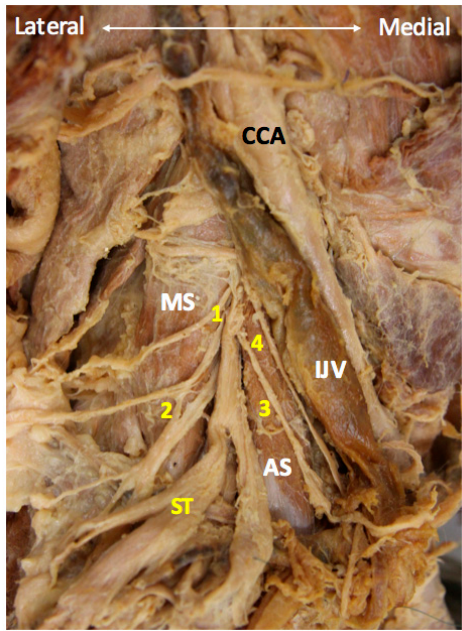
Figure 8. The long thoracic and dorsal scapular nerves cadaveric models. 1: dorsal scapular nerve; 2: long thoracic nerve; 3 phrenic nerve; 4: vagus nerve. AS: anterior scalene muscle; CCA: common carotid artery; IJV: internal jugular vein; MS: middle scalene muscle; ST: superior trunk.